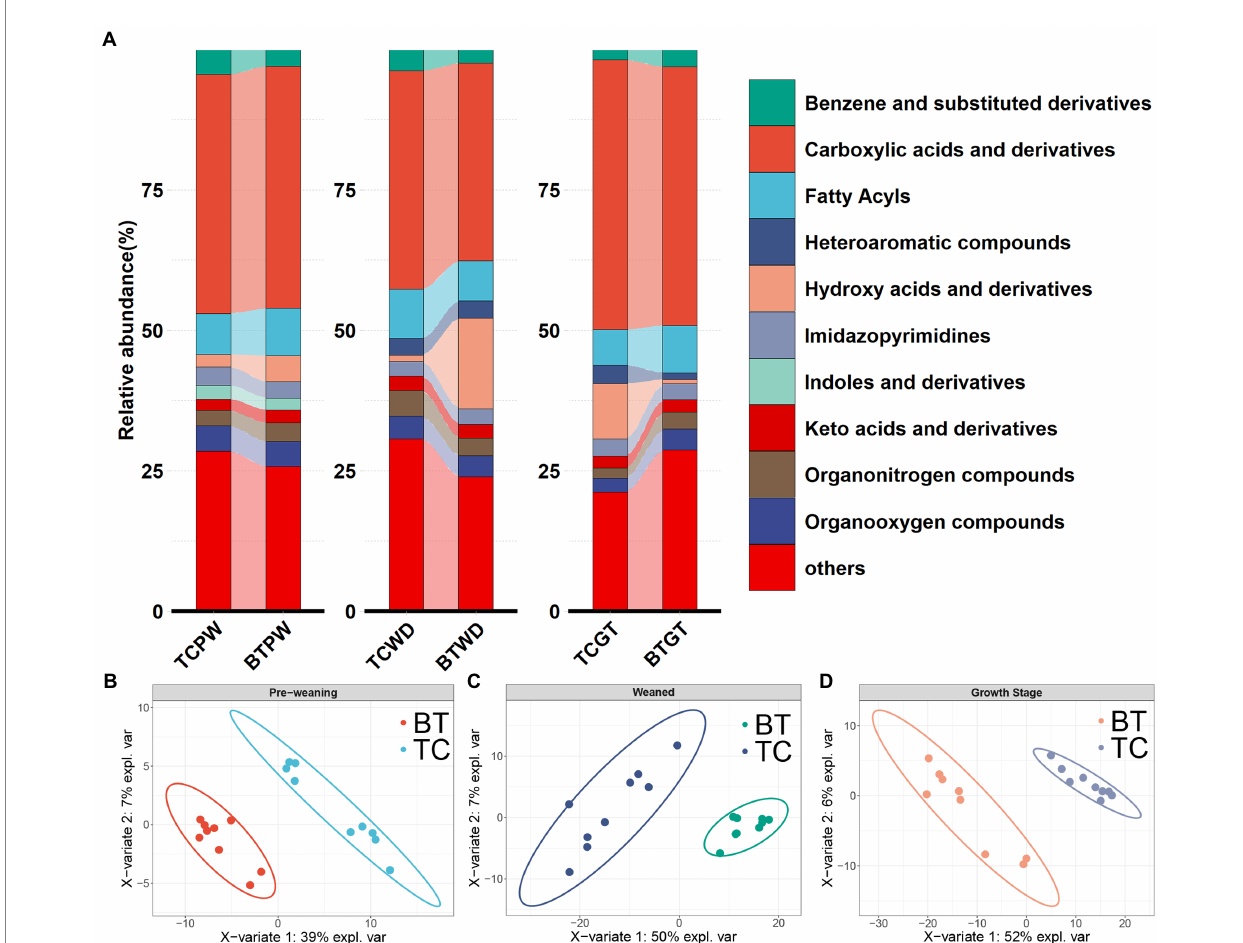
FIGURE 9 Metabolic composition and pattern were altered by hybridization. (A) Intestinal metabolite class composition according to relative metabolite masses (sum of standardized abundances), metabolites were deduced from the top 10 primary metabolites which accounted for more than 80% of the total metabolites. The PLS-DA model of intestinal metabolome analysis was performed on TC pigs and BT pigs at (B) the pre-weaning stage, (C) the weaned stage, and (D) the growth